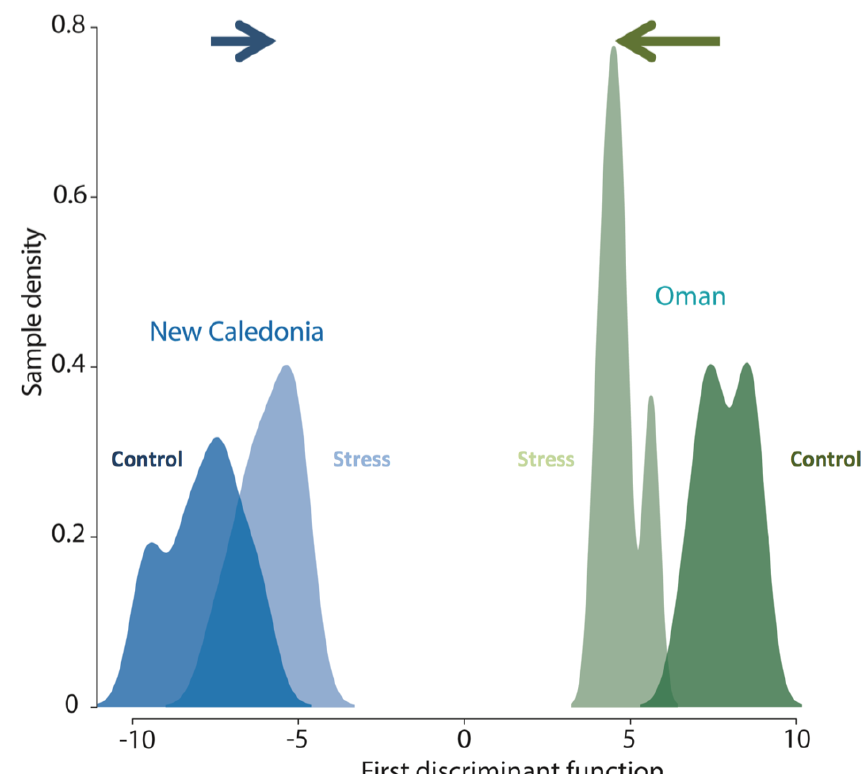
Figure 7 . Colony level gene expression variation in response to heat stress, based on DAPC analysis. The x-axis is the first discriminant function of the DAPC along which the overall gene expression difference between colonies at both experimental conditions (stress and control) and from both localities (NC and Om) was maximized. This indicates the degree of similarity between the transcriptomes. The density plots obtained for NC and Om colonies are represented in blue and green, respectively. Dark and light density plots correspond to samples from the control and stress experimental conditions. The arrows above the density plots represent the direction of the mean change in the gene expression